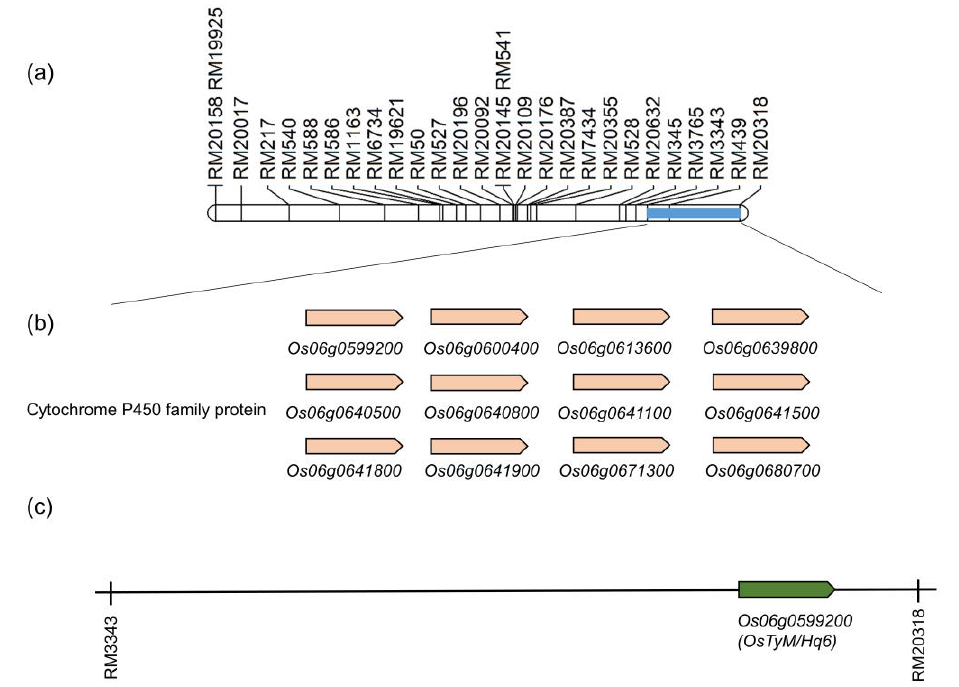
Figure 5. Physical mapping of genes related to lodging resistance to typhoons. ( a ) Target interval RM3343 – RM20318 on chromosome 6. ( b ) 12 related genes belonging to cytochrome P450 family protein, selected as related genes between RM3343 and RM20318 on chromosome 6. ( c ) Screening of OsTyM/Hq6 , among the related genes, as a target gene-related to lodging resistance to typhoons.